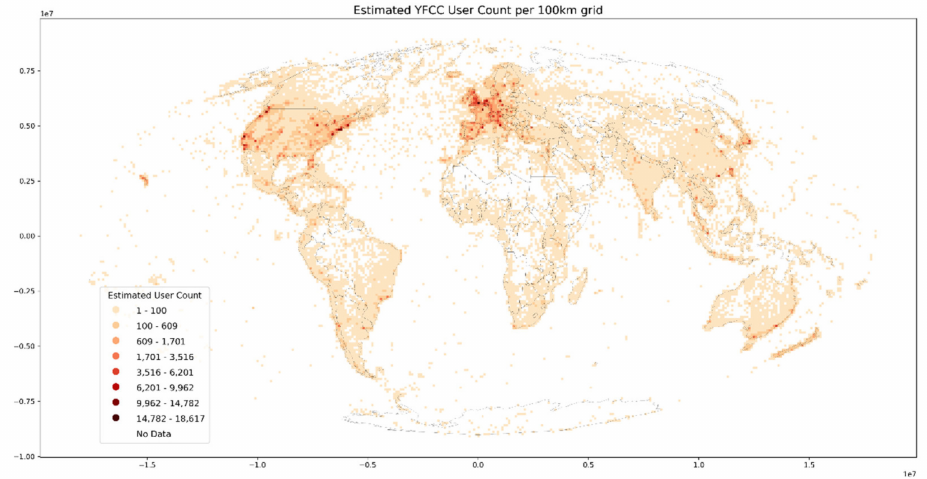
Figure A1. Worldwide map of estimated user counts (YFCC) per 100 km grid bin.